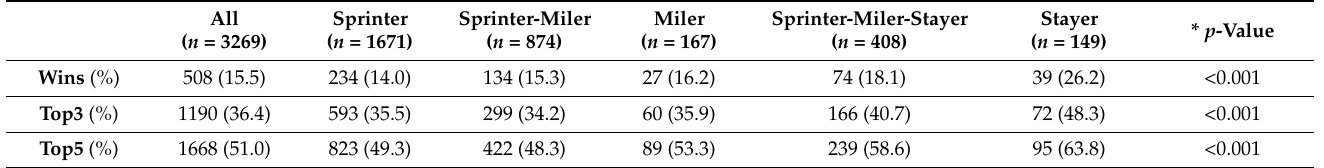
Table 1. Race performance stratified by type of